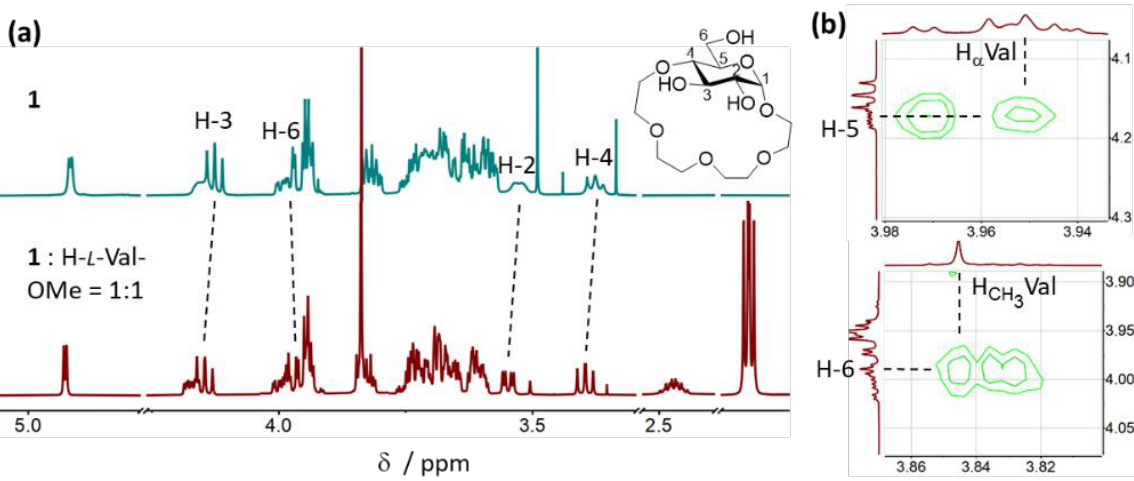
Figure 5. ( a ) 1 H NMR spectra in CDCl 3 of 1 (top) and 1 + H- L -Val-OMe × HCl (bottom). ( b ) Through- space interactions observed in the NOESY spectra of the 1:1 complex.